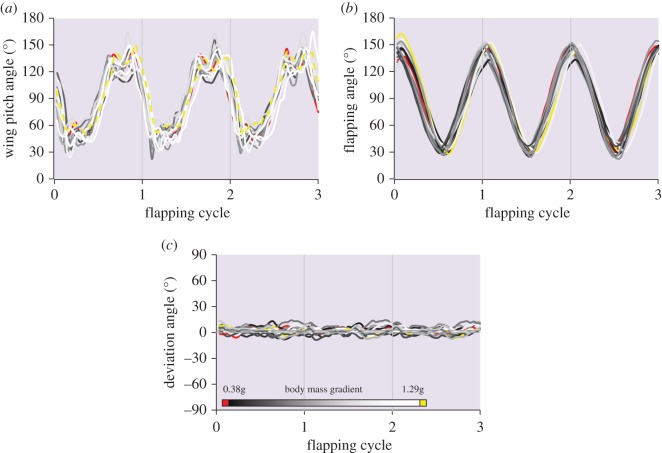
Flapping kinematics. Time-varying wing pitch (a), flapping (b) and deviation (c) angles of the 14 beetles used in the study during three consecutive flapping cycles. Greyscale colour code denotes ranked body mass from lowest (dark) to highest (light). The smallest and largest beetles are denoted by red and yellow, respectively.